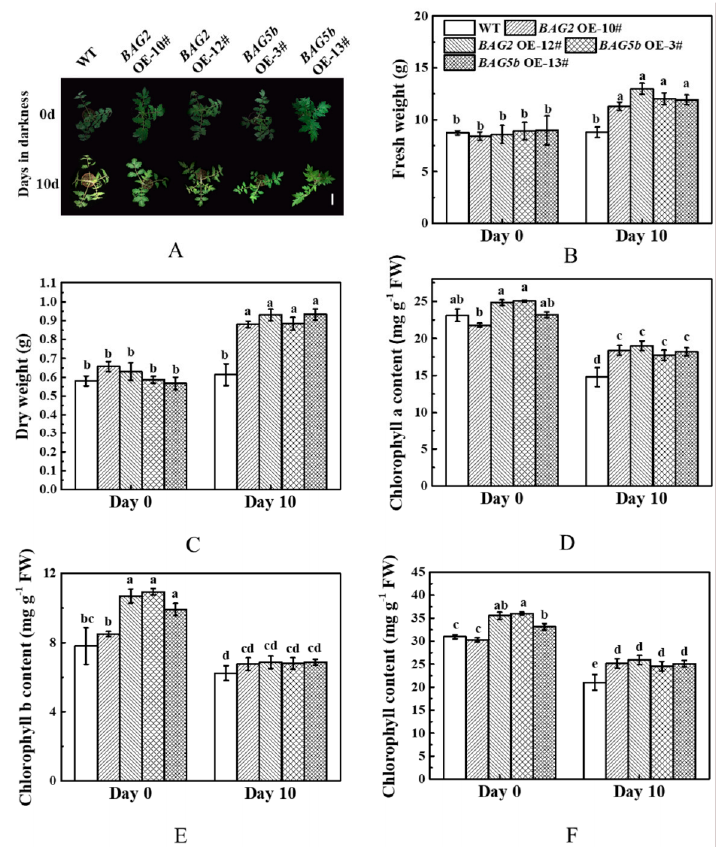
Figure 9. Effects of dark stress on the growth of WT and plants overexpressing BAG2 or BAG5b . ( A ): Photographs of plant phenotypes were taken 0 d and 10 d after dark stress; ( B ): fresh weight; ( C ): dry weight; ( D – F ): chlorophyll content. Different letters indicate that each indicator was significantly different at P < 0.05. 10# and 12# represent 2 lines of BAG2 OE plants; 3# and 13# represent 2 lines of BAG5b OE plants; OE, overexpression; WT, wild type. Bars = 10